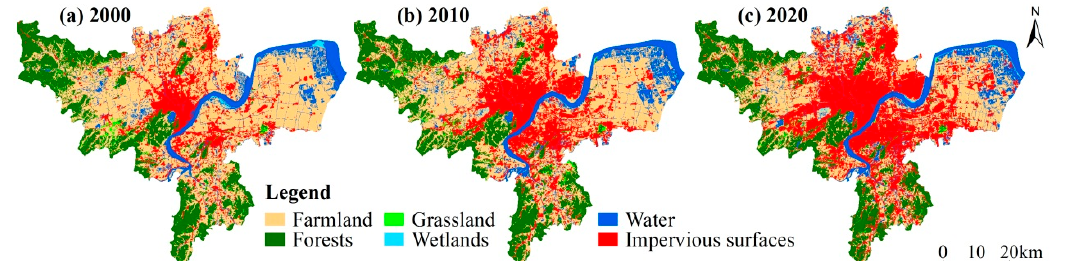
Figure 3. Land-use maps of Hangzhou City from 2000 to 2020.